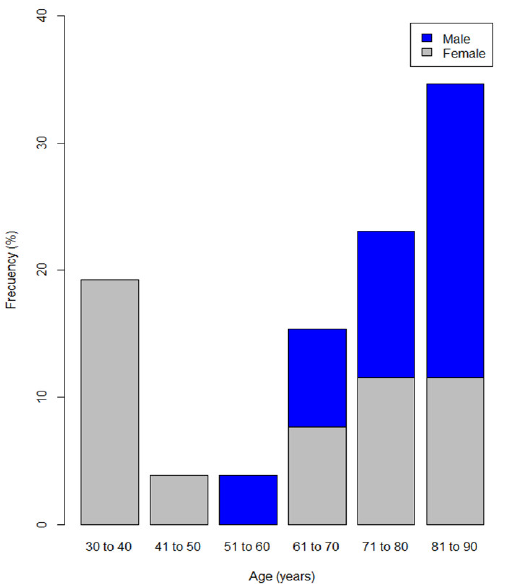
Figure 1. Distribution of patients diagnosed with acquired haemophilia A by age range and sex.